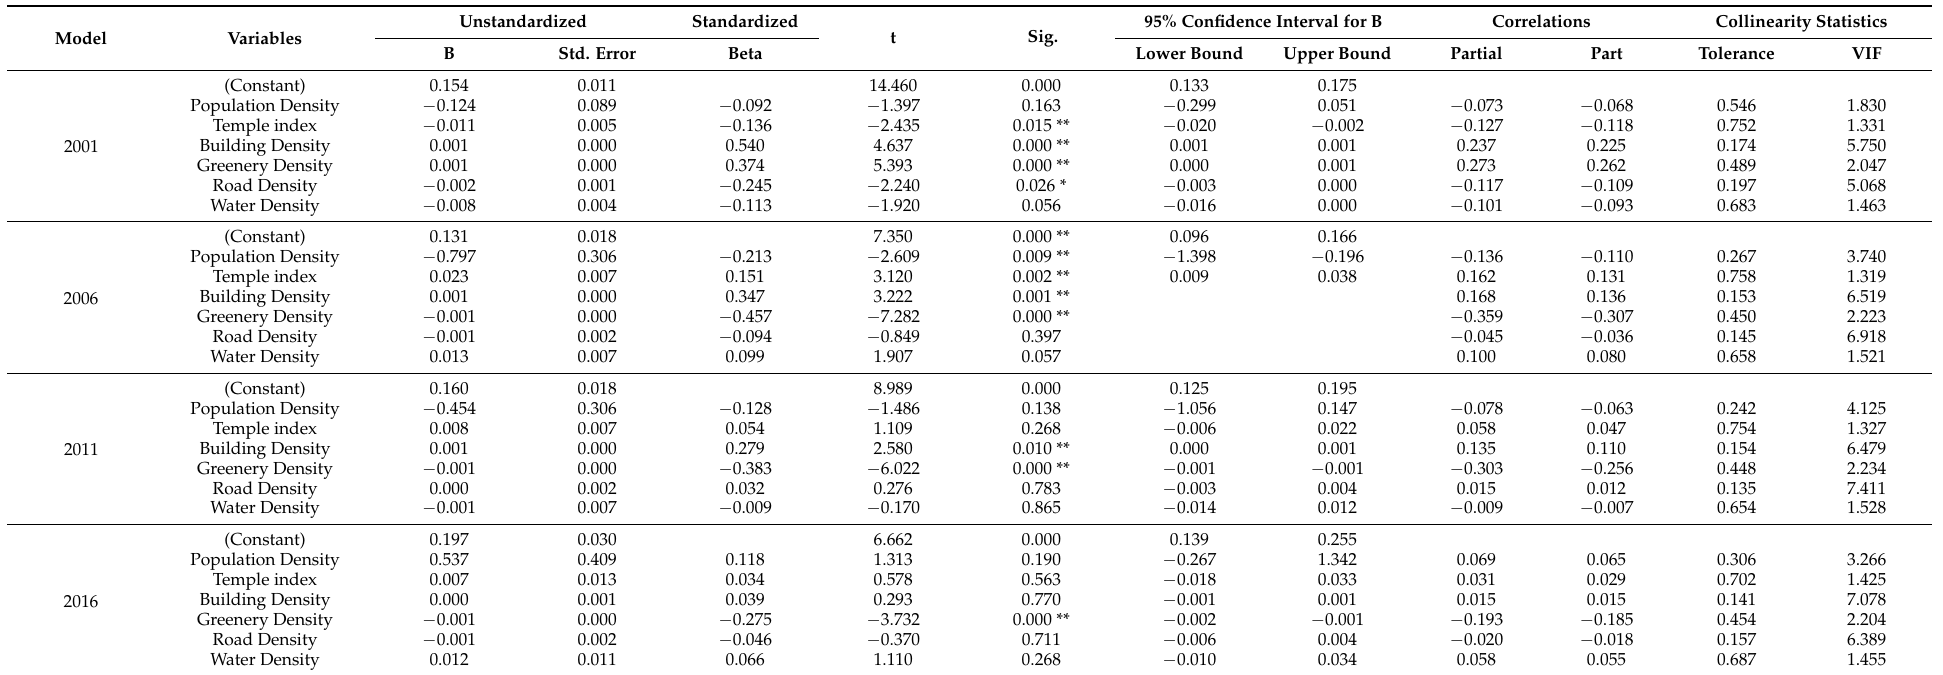
Table 6. Linear Regression Model Coefficients (in 2001, temple index, building density, greenery density, and road density were significantly correlated with respiratory mortality at the 95% confidence level; in 2006 and 2011, population density, temple index, building density, and greenery density were significantly correlated with respiratory mortality at the 95% confidence level, but only building density and greenery density had a response; in 2016, only greenery density was statistically